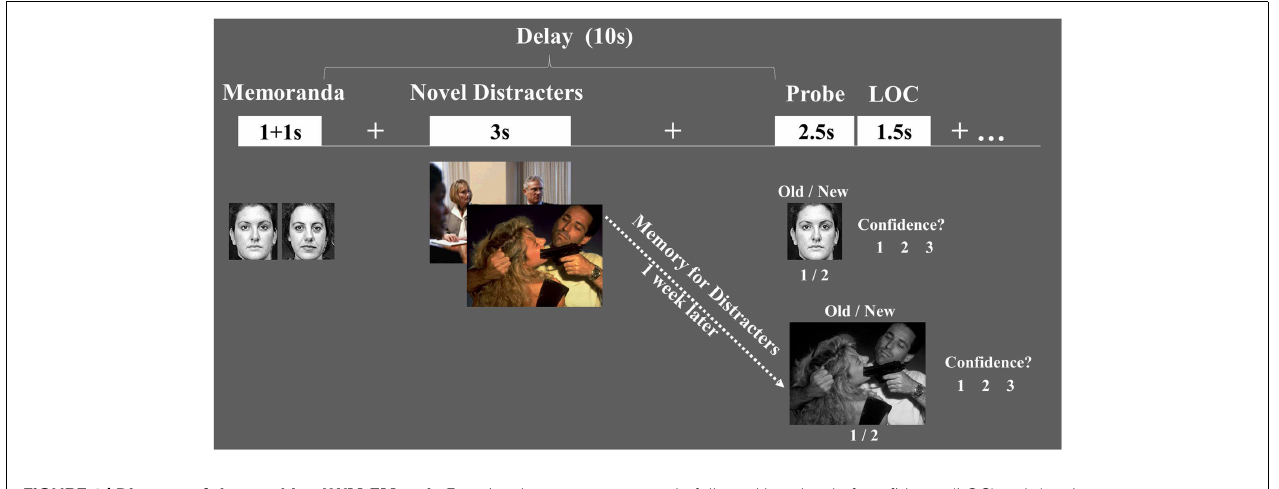
FIGURE 1 | Diagram of the combinedWM-EM task . Functional magnetic resonance imaging (fMRI) data were recorded while subjects performed a working memory (WM) task with distraction.WM performance was measured using an Old/New recognition memory